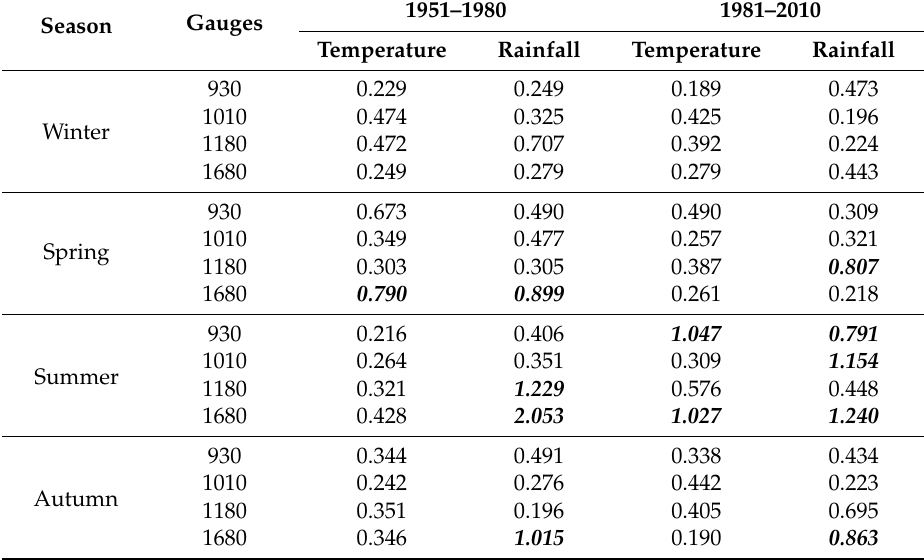
Table 3. Anderson–Darling statistic for temperature and rainfall series. Critical values for different N have been assumed at the 95% confidence level. (The cases in which the normality hypothesis is rejected are in bold italics.)